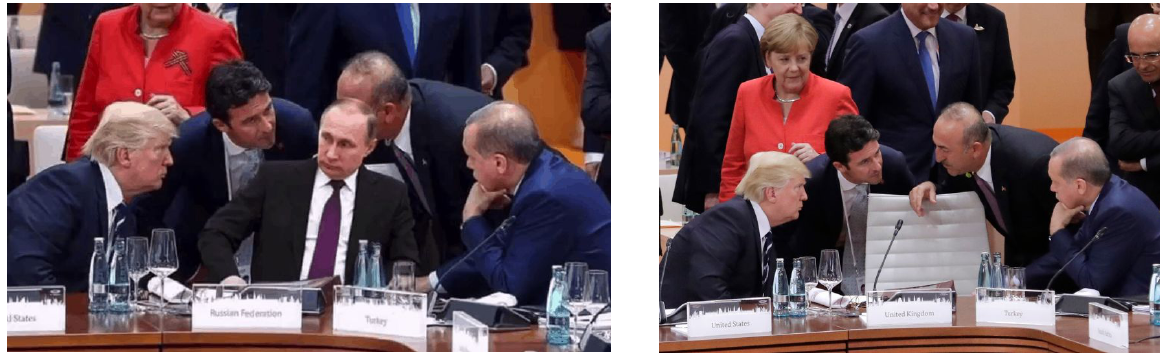
Figure 3 - Example of image splicing, which circulated in social media in 2017. The left figure depicts an image composition while the right one depicts the host image used to construct the fake one. Source: Gizmodo (Novak